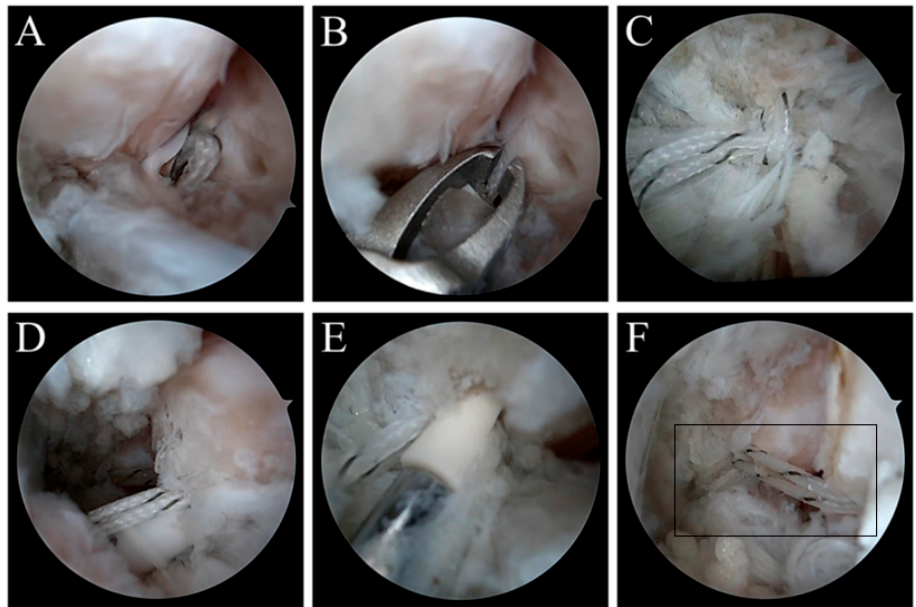
Figure 2. ATFL suture augmentation repair under total arthroscopy. ( A ): Line crossing. ( B ): Line grasping. ( C ): Ring sleeve. ( D ): The fibula side was implanted with knotless anchor. ( E ): The talus side was implanted with knotless anchor. ( F ): Postoperative effect.